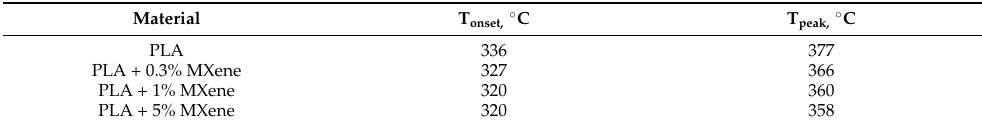
Table 2. The decomposition temperature of PLA and nanocomposites.